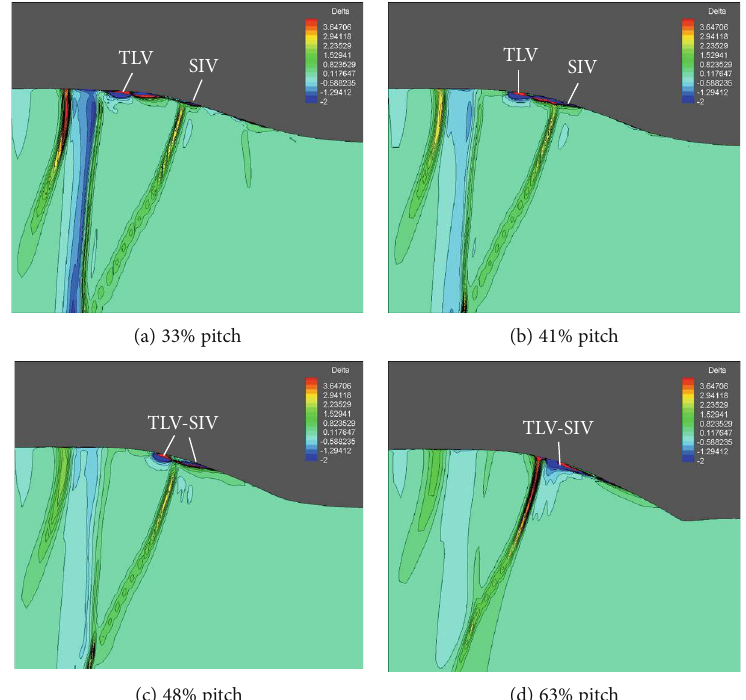
Figure 25: Discrimination of shock-induced vortex stability by parameter Delta at near stall condition.